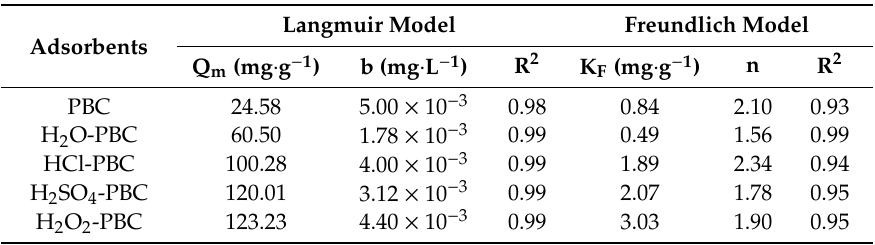
Table 2. Fitting parameters for the Langmuir and Freundlich isotherms of NH 4 + -N adsorption in an aqueous solution on the di ff erently treated